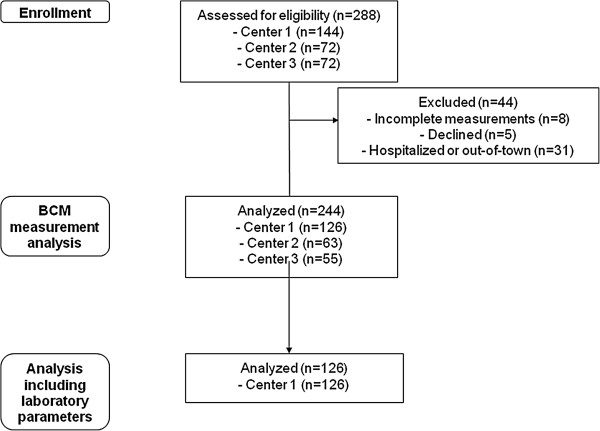
Patient enrollment according to CONSORT flowchart.